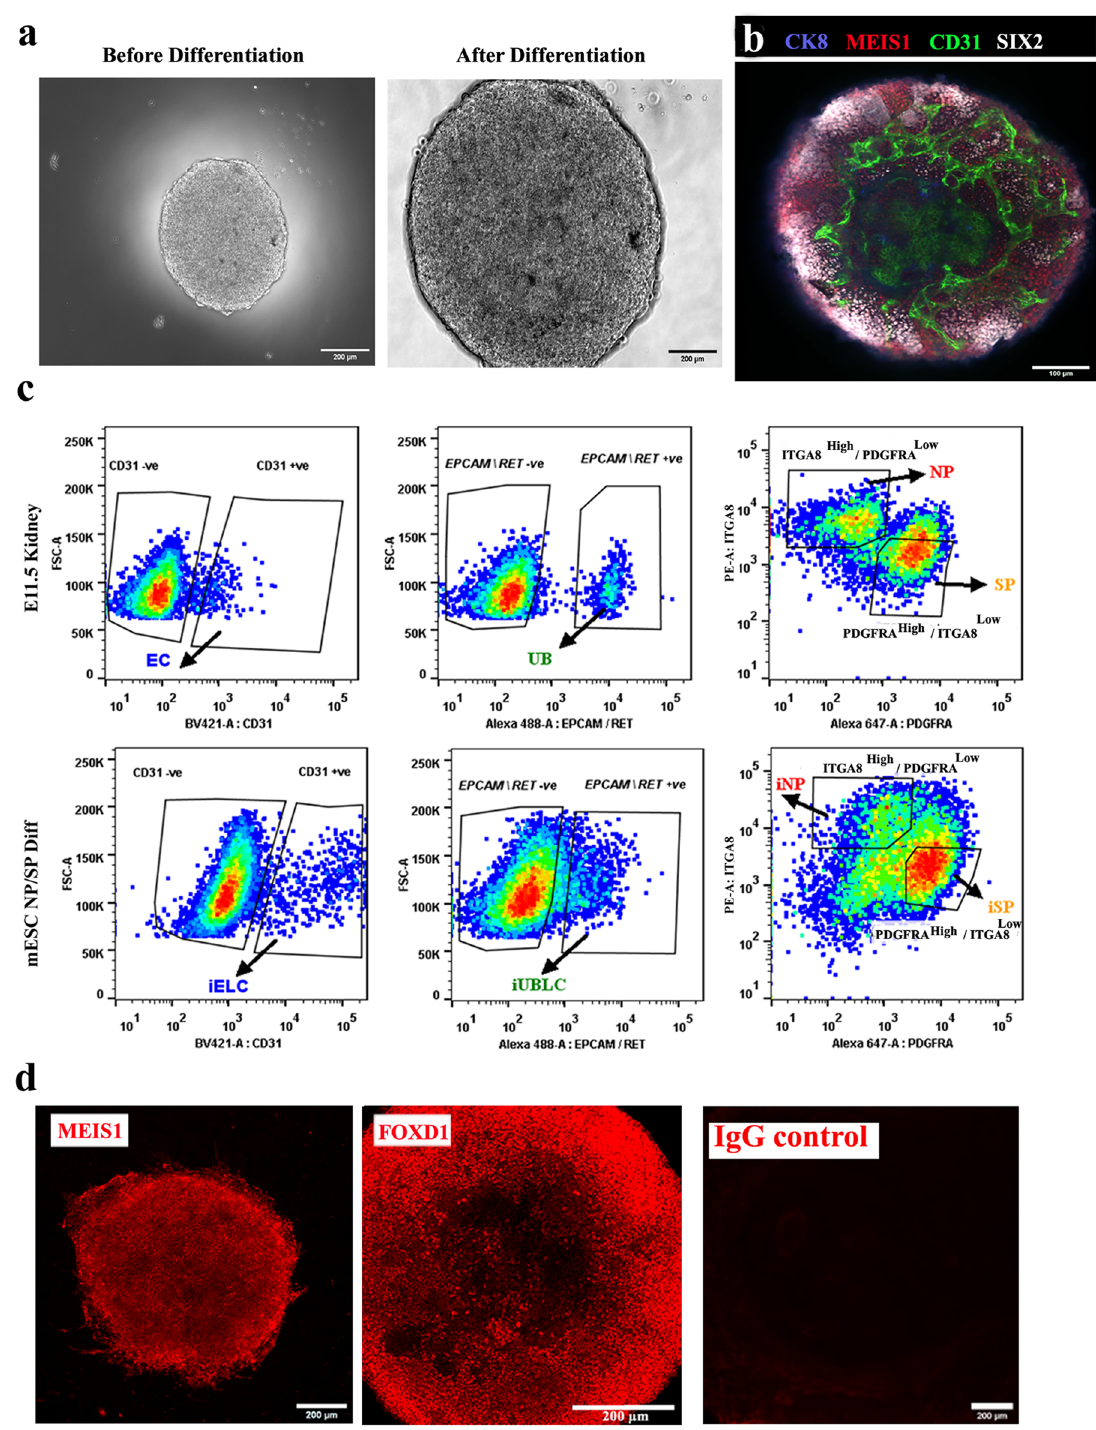
Figure 2. Differentiation of mESC to nephron and stromal progenitors (iNP, iSP). ( a ) Representative images of embryoid bodies before (48 h) and after differentiation (228 h). Scale bar, 200 µm. ( b ) Immunostaining for endothelial (CD31), ureteric bud (CK8), nephron progenitor (SIX2) and stromal progenitors (MEIS1) in differentiated embryoid bodies. n = 5/5. Scale bar, 100 µm. ( c ) Representative flow cytometry data of E11.5 kidney and differentiated embryoid bodies (mESC NP/SP Diff) showing the ITGA8 high /PDGFRA low gate for NP/iNP cells and the INTGA8 low / PDGFRA high gate for SP/iSP) cells. Ureteric bud (EpCAM/RET + ve) and endothelial cells (CD31) were negatively gated before sorting NP/iNP and SP/iSP cells. Abbreviations: EC: endothelial cells, UB: ureteric bud, iELC: induced endothelial like cells, eUBLC: engineered ureteric bud like cells. ( d ) Immunostaining for MEIS1 and FOXD1 in sorted iSP cells. n = 3/3. Scale bar, 200